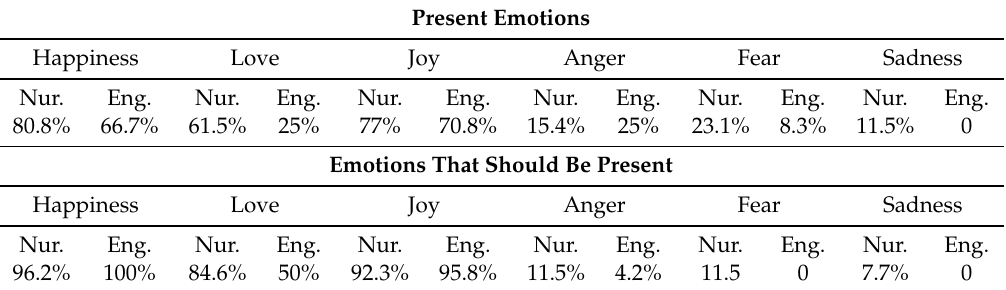
Table 5. Emotions post-intervention.